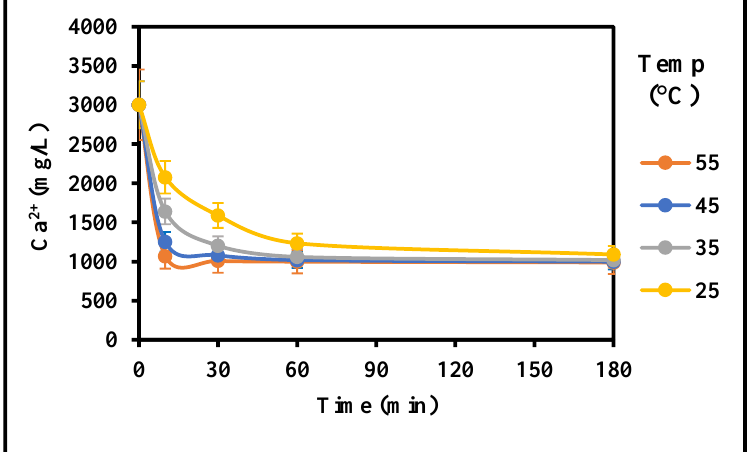
where R—rate; k—; S—Surface area; C—CaSO 4 concentration; C 0 —Equilibrium CaSO 4 Figure 3. Determination of the reaction order. concentration.